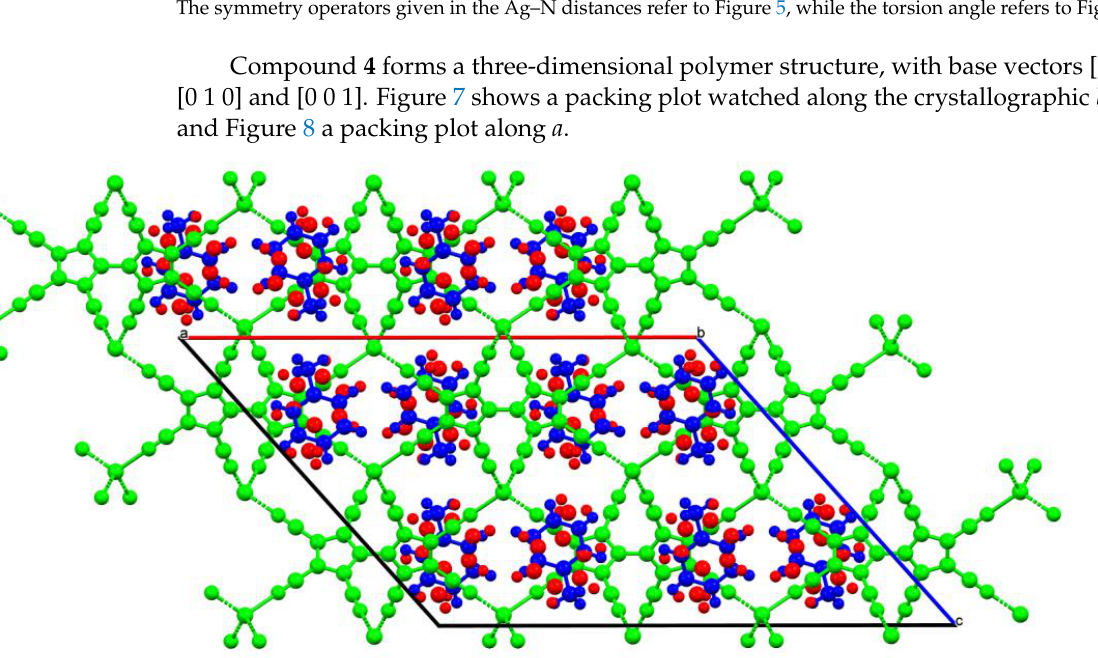
Table 2. Important bond parameters of compound 4 (low-temperature determination).